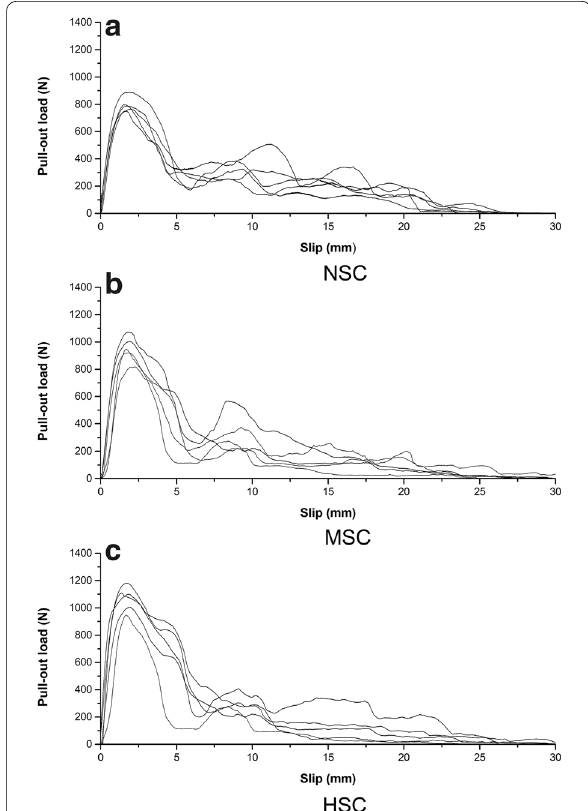
Fig. 8 Pull-out-slip curves of 5DH hooked-end steel fibres. a NSC, b MSC and c HSC matrix.